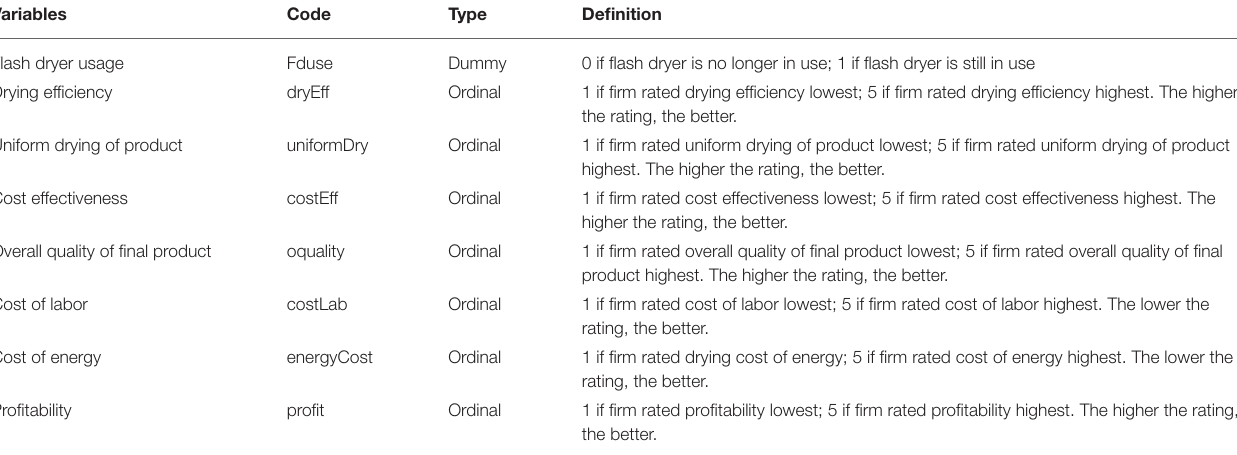
TABLE 1 | Variables used in the logistic